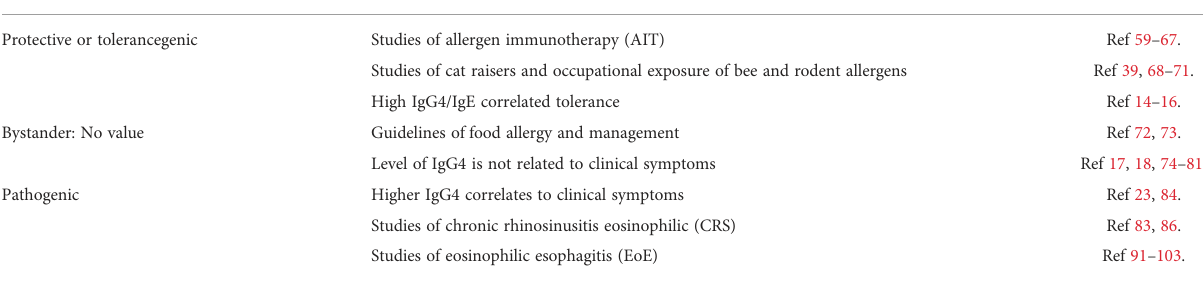
TABLE 1 Three viewpoints of clinical correlation of IgG4 in allergic diseases.